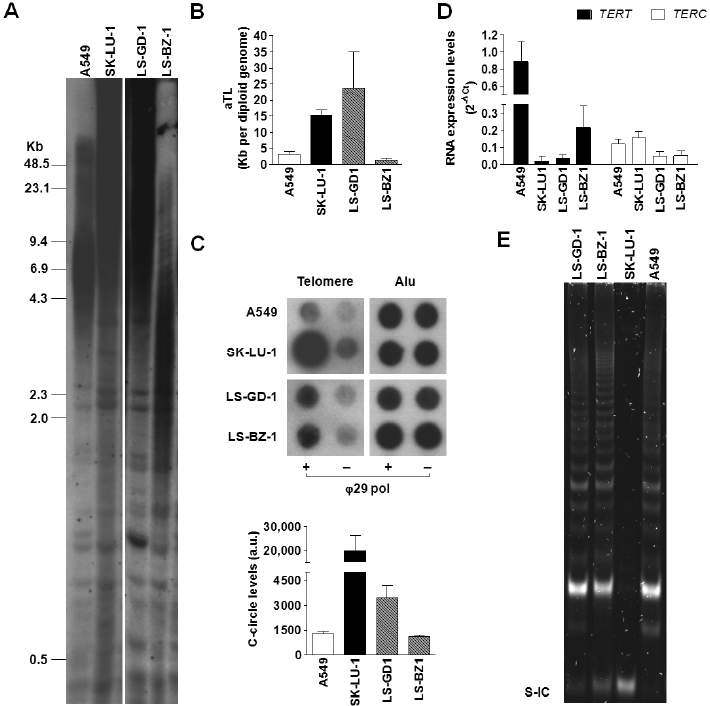
Figure 2. Characterization of TMM in DDLPS cell lines. ( A ) Representative image showing the distribution of TRFs assessed by Southern blot on total DNA obtained from LS-GD-1 and LS-BZ-1 cells. Numbers on the left indicate the molecular size (Kb, kilobases) of DNA fragments; ( B ) Real-time PCR quantification of absolute telomere length (aTL). Data have been reported as Kb per diploid genome, according to the manufacturer’s instructions, and represent mean values ± s.d. from at least three independent experiments. ( C ) Representative image of a dot blot from a CCA showing the basal levels of telomeric C-circles in total DNA from LS-GD-1 and LS-BZ-1 cells. The graph on the bottom shows the quantification of c-circle levels. Data have been reported as means ± s.d. of [( ϕ 29+) − ( ϕ 29 − )] densitometric values of telomeric probe from three independent experiments; a.u.: Arbitrary units. ( D ) Real-time RT-PCR assessment of the expression levels of human telomerase reverse transcriptase subunit (TERT) mRNA and its long non-coding RNA partner (TERC). Data have been reported as 2 −Δ Ct and represent mean values ± s.d. ( E ) Representative image of a TRAP assay carried out on protein extracts obtained from LS-GD-1 and LS-BZ-1 cells. S-IC: 36 bp internal standard. Total DNA/RNA and protein extracts from the telomerase-positive A549 and SK-LU-1 cell lines have been included as internal controls in each assay. For the original, uncropped blots/gels see File S1. To date, the presence of single-stranded circles comprising C-rich telomeric DNA is considered a specific and quantifiable marker of ALT activity [31]. Results obtained by the CCA showed that DDLPS cell lines were characterized by quantifiable levels of c-circle DNA (Figure 2C), though in remarkably lower amounts with respect to those detected in the ALT-positive SK-LU-1 cell line (Figure 2C). Notably, A549 cells included in the assay as te- lomerase-positive controls showed quantifiable levels of c-circle that were comparable to that